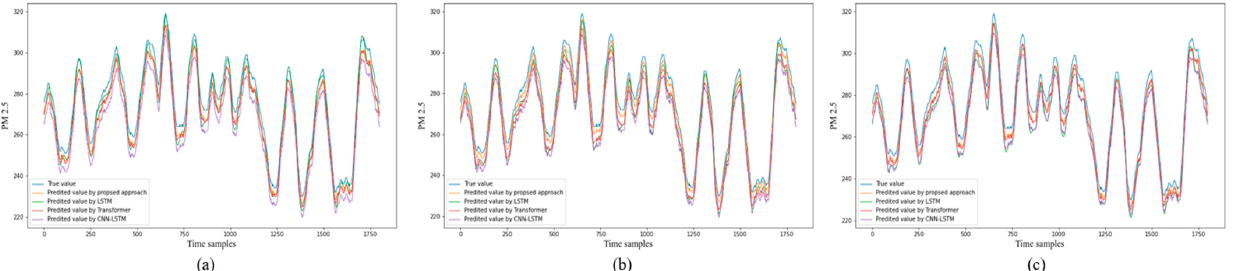
Table 2. The 5 min ahead forecasting performance of LSTM, CNN-LSTM, Transformer models, and our proposed ap-